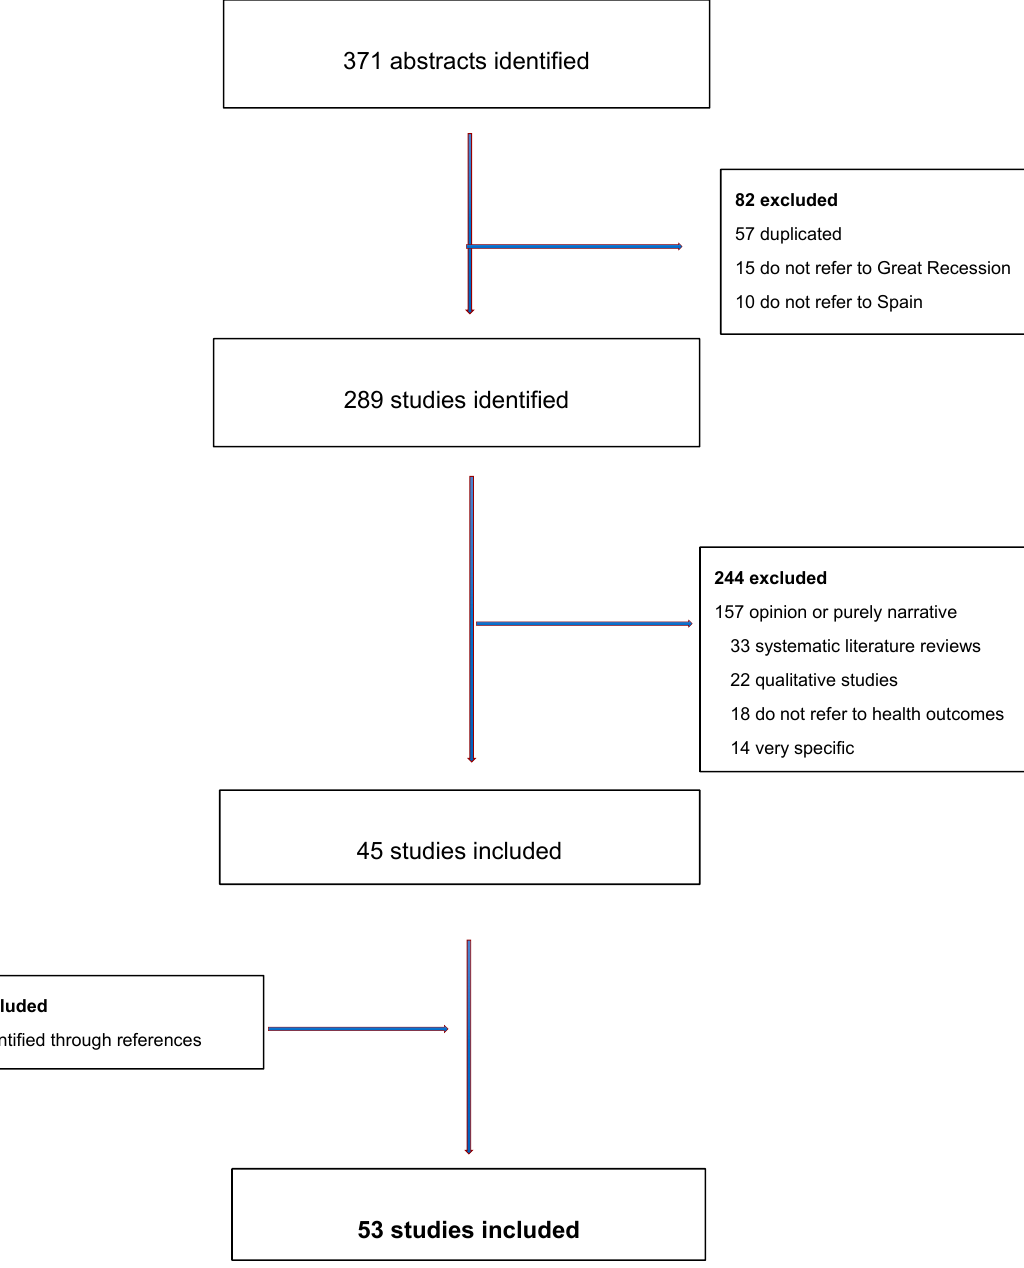
Figure 1. Flowchart of the selection of studies.